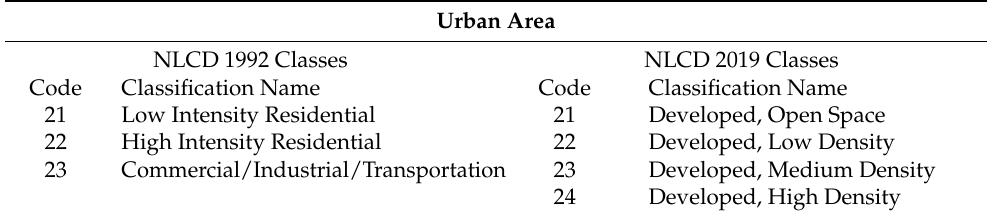
Table 1. Urban area classes for 1992 and 2019 NLCD.